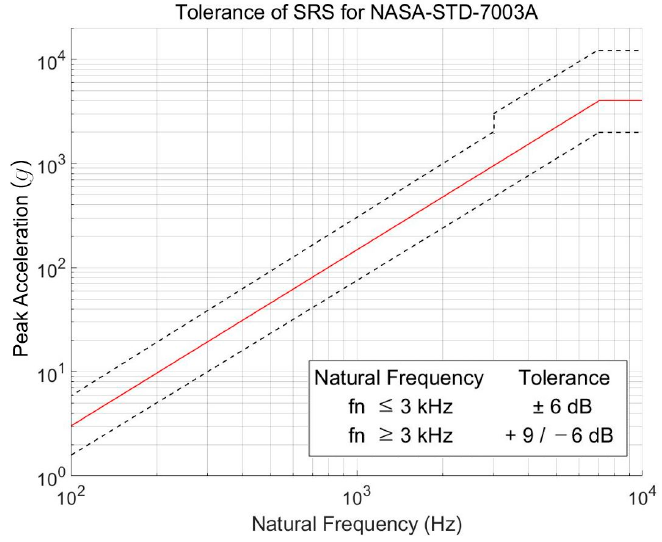
Figure 7. Test tolerance of NASA’s pyroshock environment.